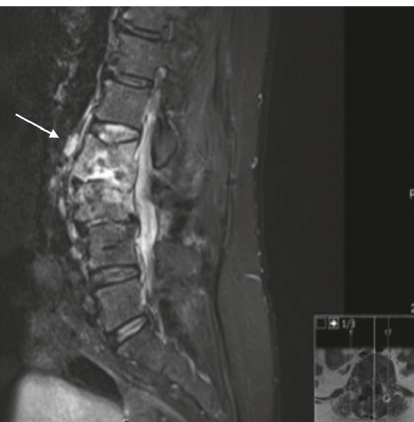
Figure 1: Case 2: sagittal T2-weighted image showing lytic lesions at L2 and L3 vertebral bodies, intervertebral disc destruction, anterior epidural abscess (white arrow), and scoliotic deformity centered in